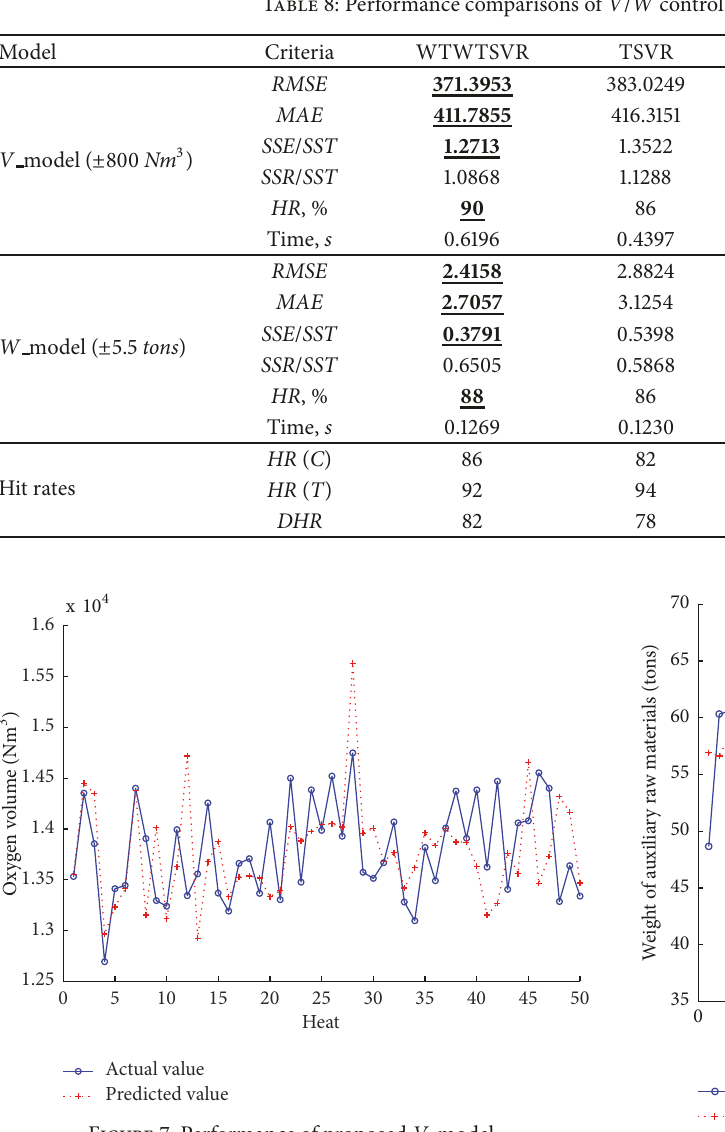
Figure 7: Performance of proposed V model.